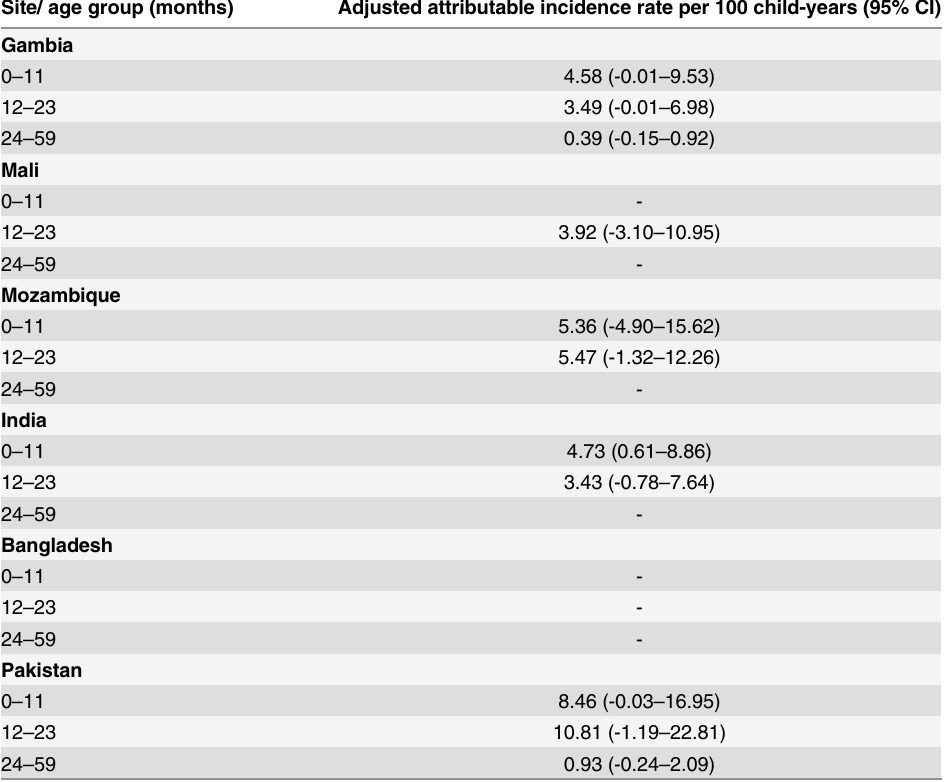
Table 2. Adjusted attributable incidence (per 100 child-years) and 95% confidence intervals (CIs) of Cryptosporidium -attributable LSD, by site and age group * . Site/ age group